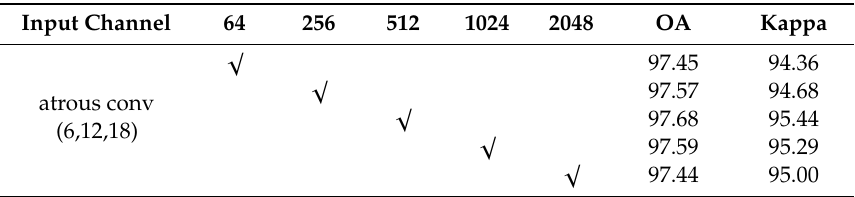
Table 2. Comparison of di ff erent ASPP input feature dimension values to evaluate the classification performance of the corresponding